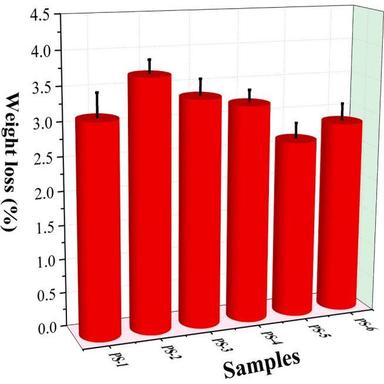
Weight loss of the EPCMs with different PW content.